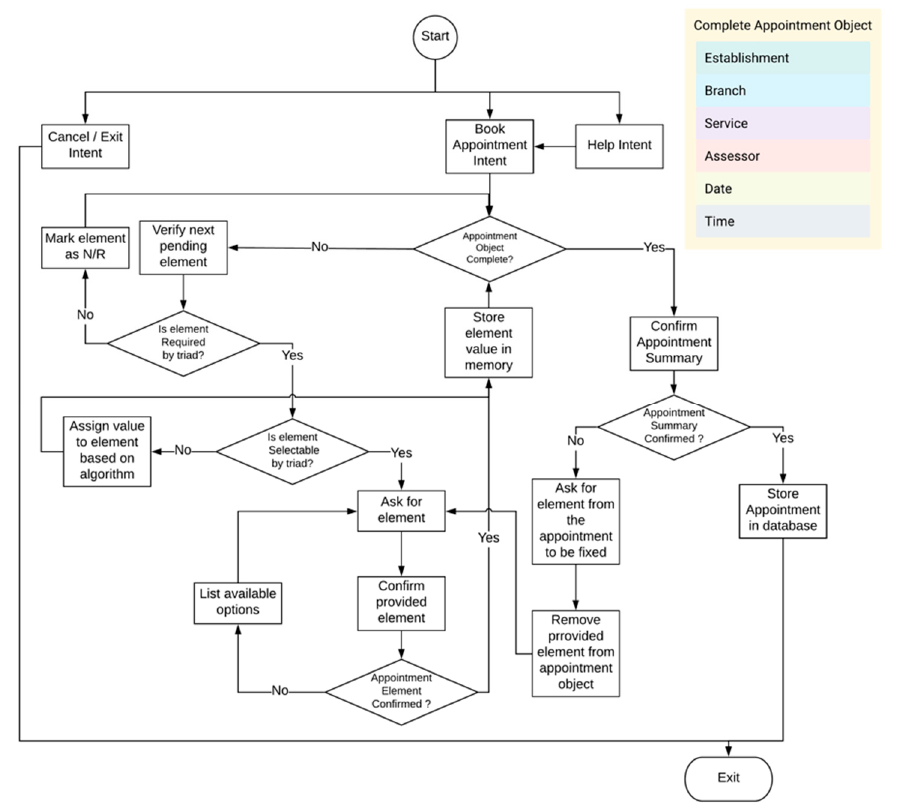
Figure 1. Appointments Architecture Main Structure and